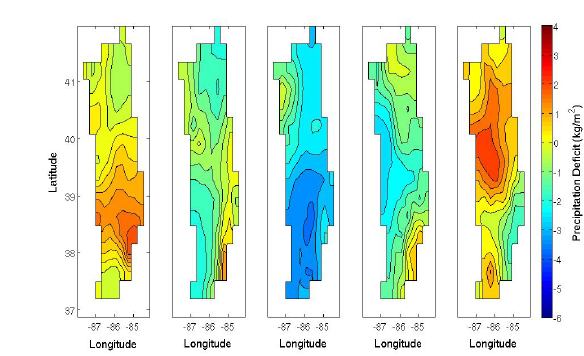
Figure 6: Spatiotemporal changes in precipitation deficit over the spring and summer months of